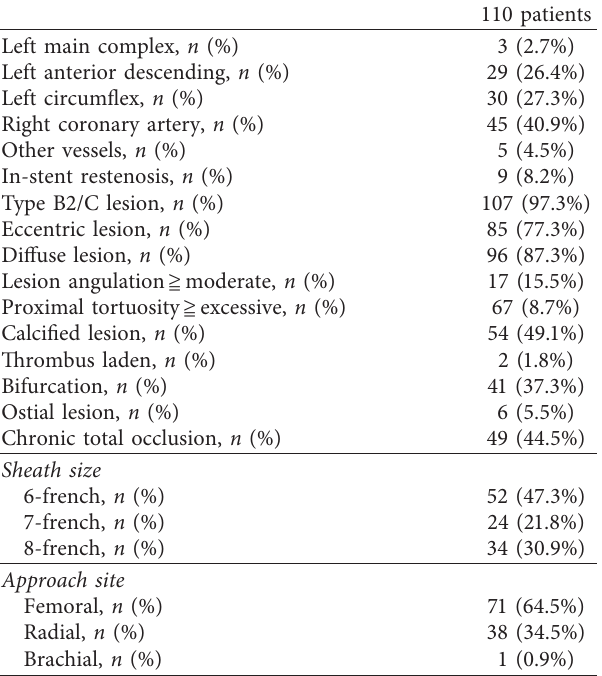
Table 2: Coronary angiographic and procedural